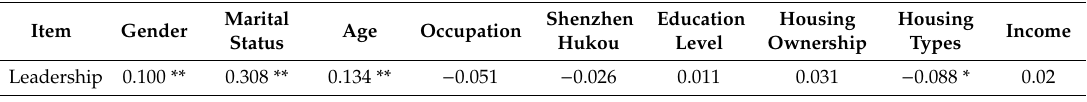
Table 7. Correlations between socio-demographic factors and perceived leadership during urban flooding